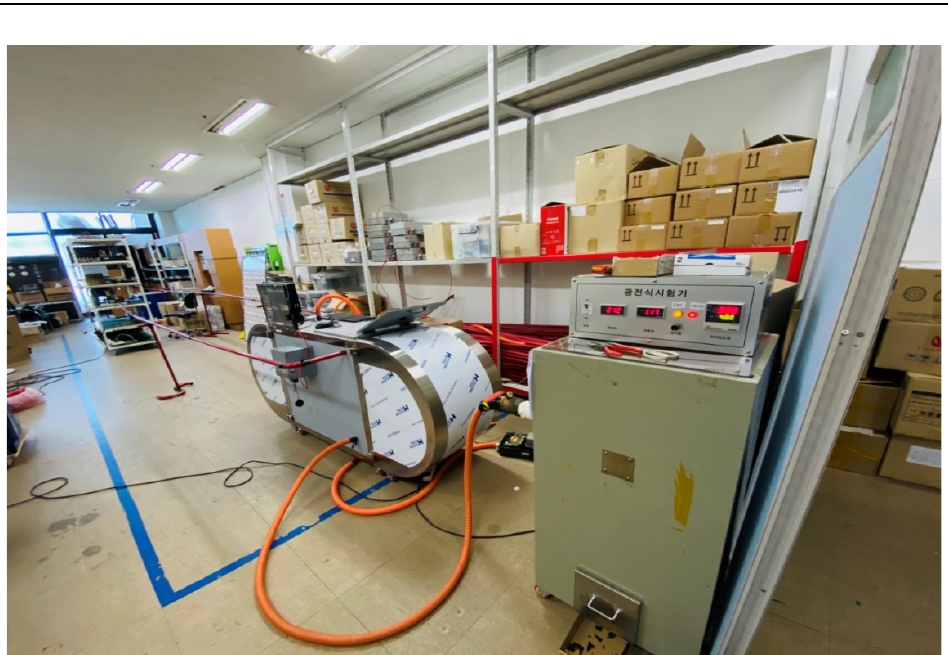
Figure A1. Experiment Pipe Network System.